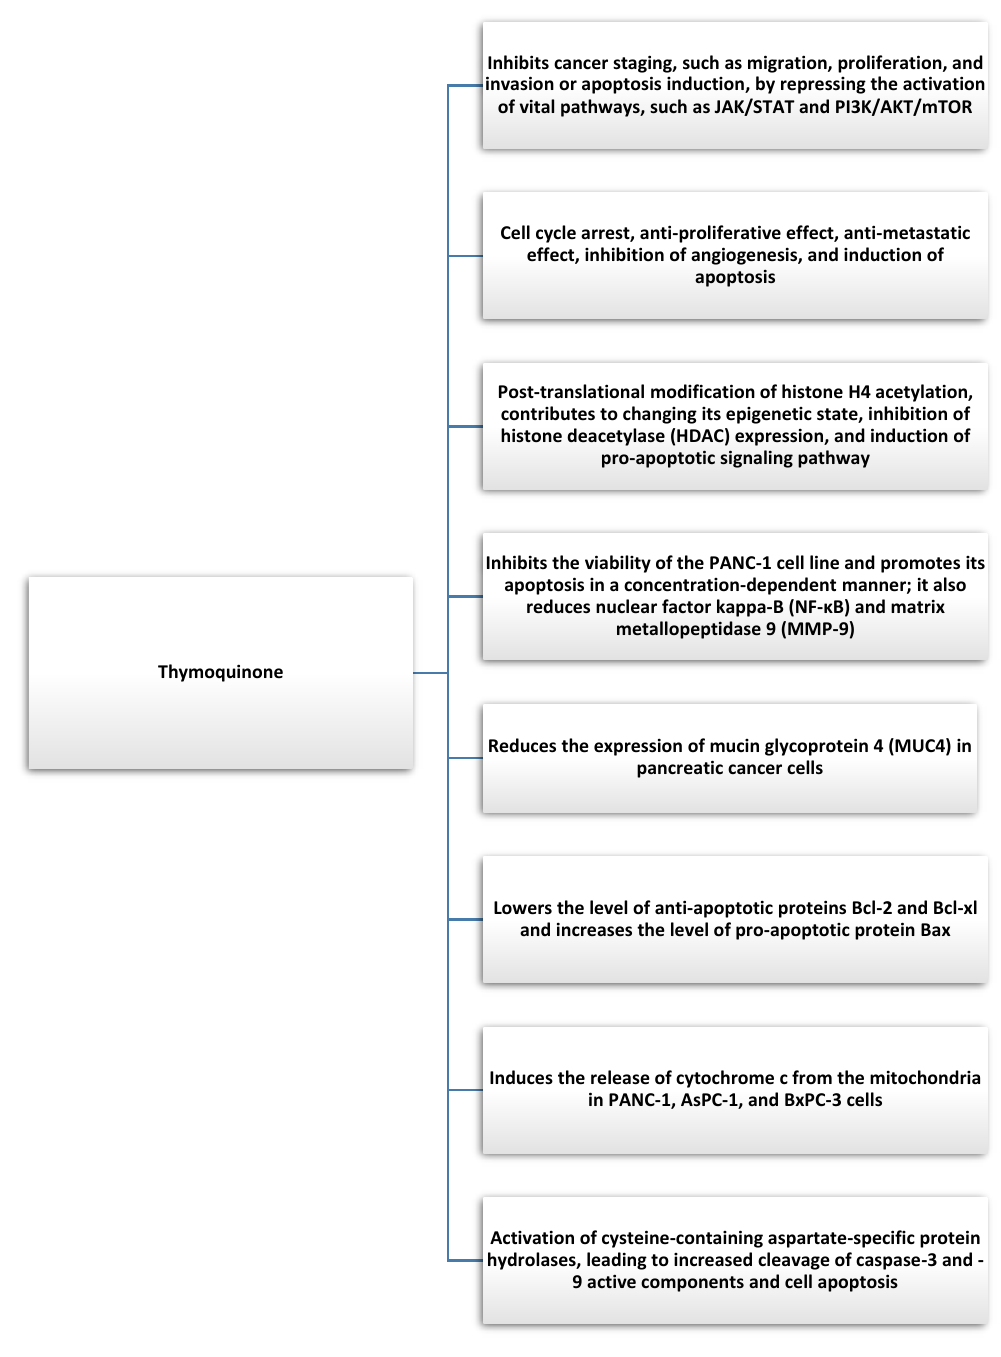
Figure 3. Anticancer effects of thymoquinone found in Nigella Sativa [49,50,52,53,55].